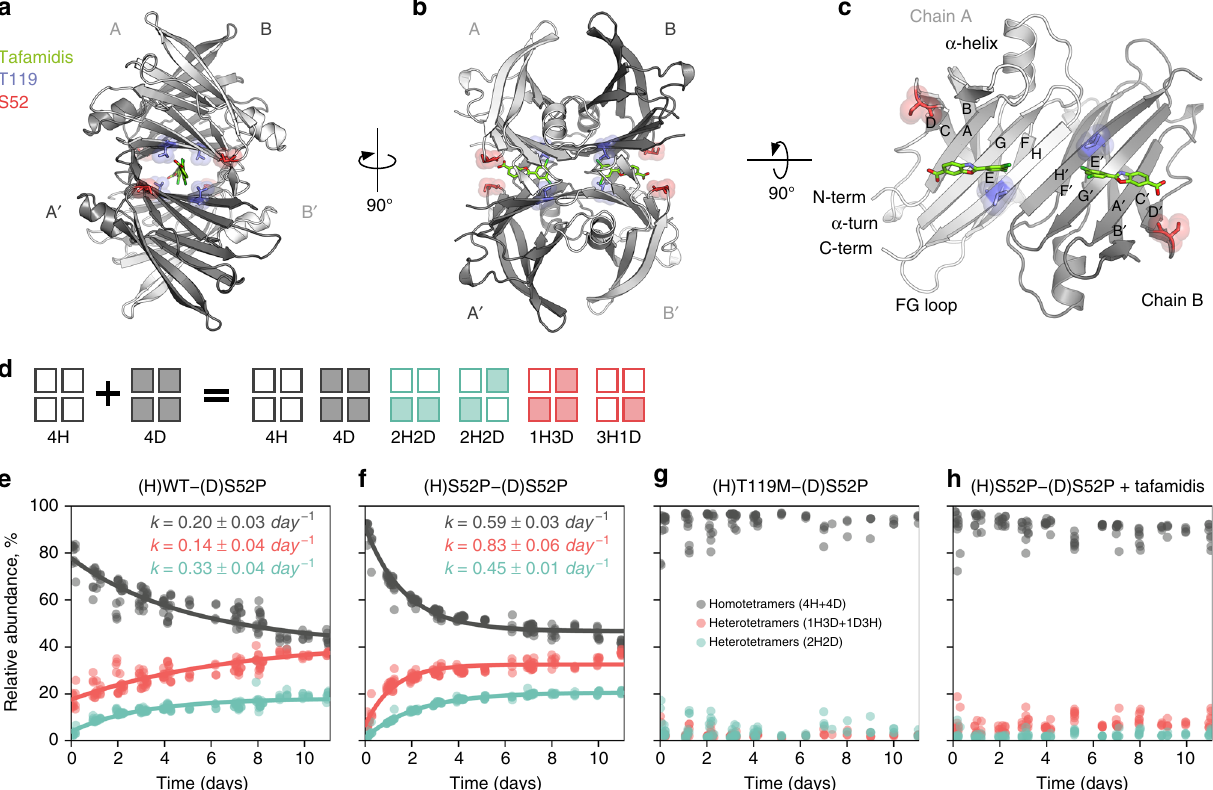
Fig. 1 Structure of human TTR and experimental studies of TTR stability. a – c Crystallographic structure of WT-TTR (PDB-ID 4PVM). Tafamidis is shown in green (by superimposition of PDB-ID 6FFT), the S52 amino acid in red, and T119 in blue. d Scheme of the native MS experiment: 4H (hydrogenated) and 4D (deuterated) tetramers are mixed in equal parts; following dissociation, four hybrid tetrameric species may form by the assembly of monomeric and dimeric species. e – h MS result for the subunit exchange between deuterated S52P and hydrogenated WT, S52P, T119M, and S52P bound to tafamidis, respectively. Changes in relative abundance of homo- and hetero-tetrameric species over the course of 11 days are shown, along with an estimate of the of their association/dissociation rates (uncertainties are one standard deviation of the posterior